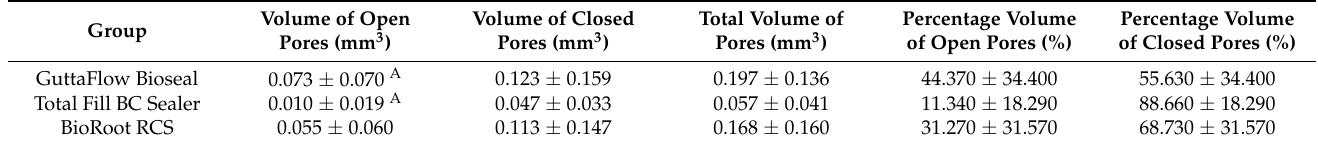
Table 3. Long-term volume and percentage of open and closed pores.